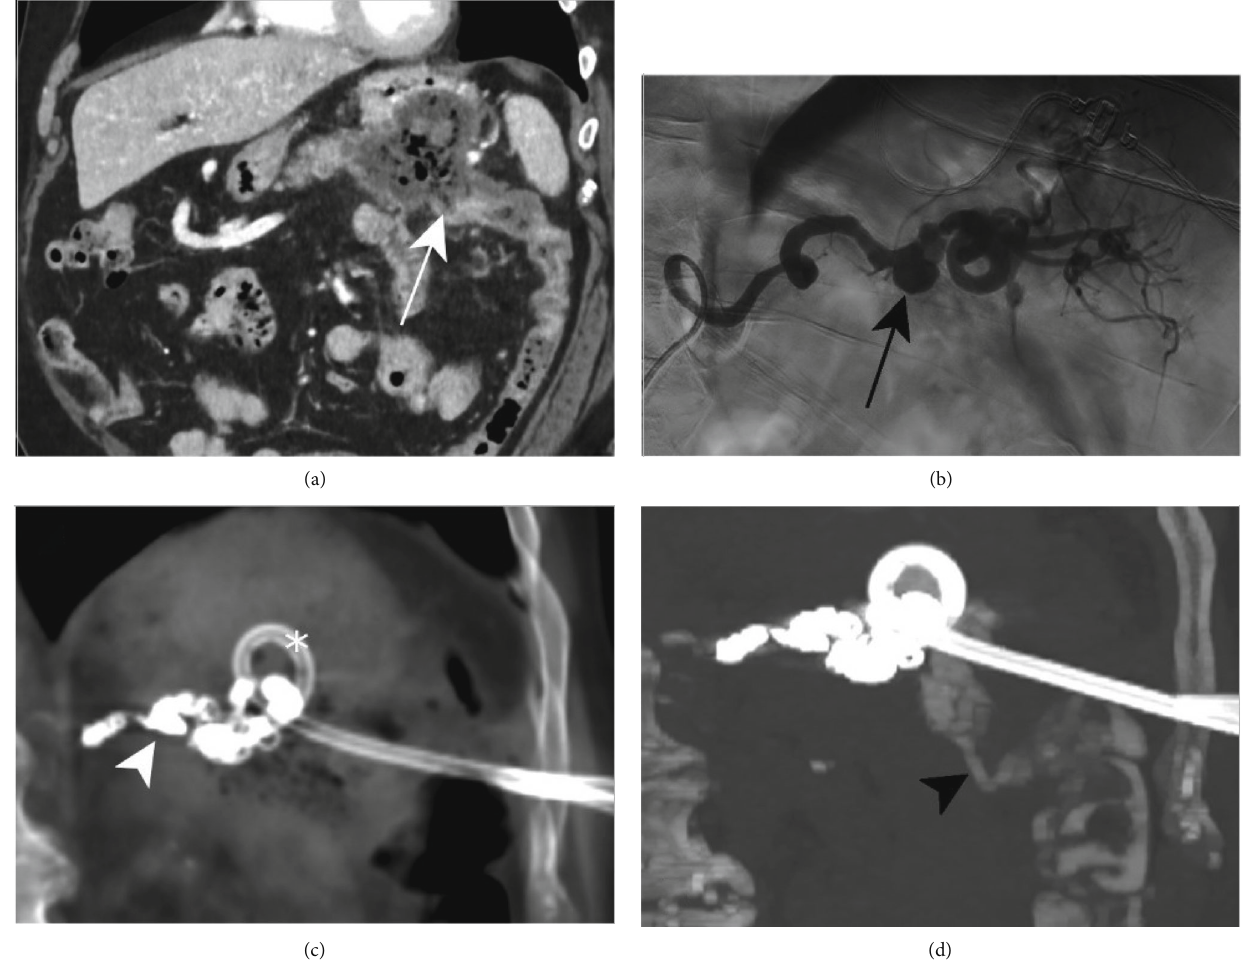
Figure 1: (a) Coronal reformatted contrast-enhanced CT demonstrates a large necrotic tumor in the pancreatic tail with suspicion of a fi stula extending to the left colic angle (white arrow). (b) Digital subtraction angiography of the splenic artery shows caliber irregularities of the proximal and middle thirds of the vessel and a 15mm diameter pseudoaneurysm (black arrow) of the middle third of the artery, without contrast extravasation; in the normal segments, the splenic artery measures 4 – 5mm of diameter. Coronal reformatted CT with maximal intensity projection before (c) and after (d) positive contrast injection through the drainage catheter (asterisk) placed in the necrotic pancreatic mass reveals a pancreatico-colic fi stula (black arrowhead) responsible for a concomitant opaci fi cation of the left colon. Images were acquired after endovascular embolization with coils (white